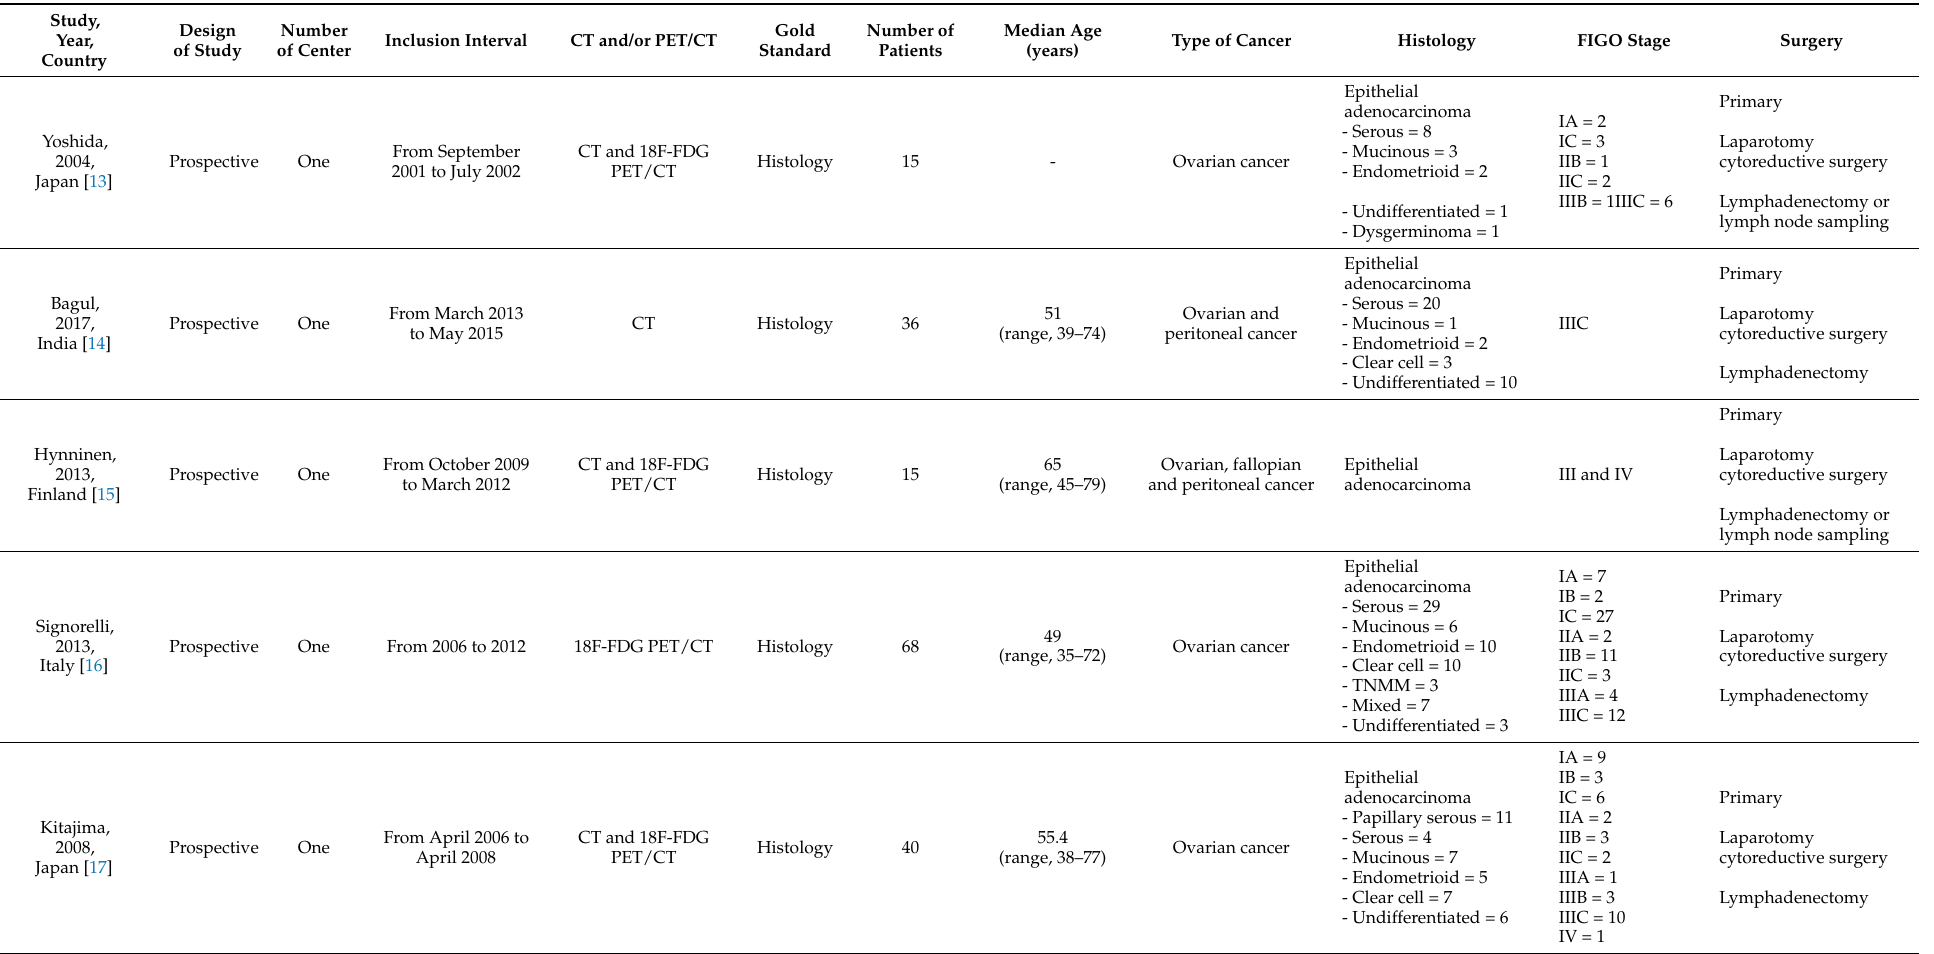
Table 1. Studies and participant characteristics included in the quantitative